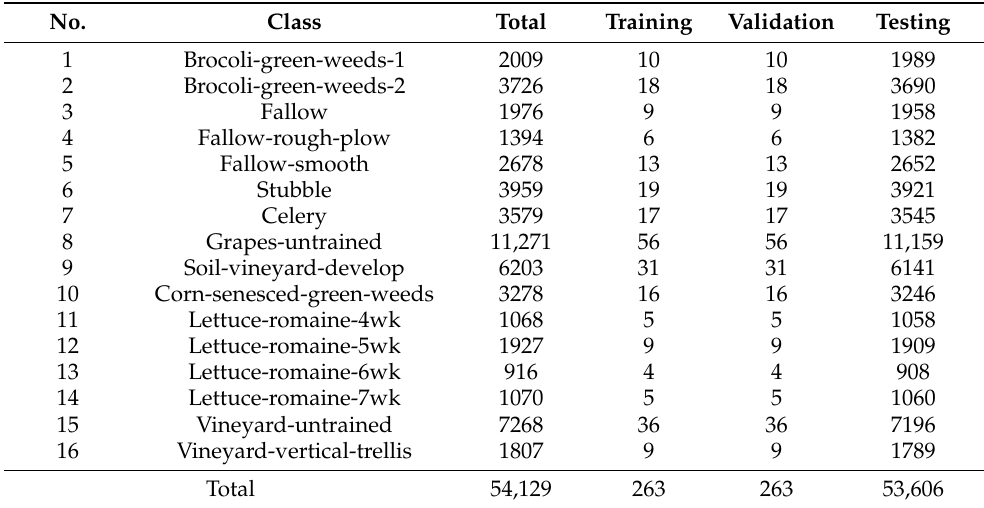
Table 2. Number of training, validation, and testing samples for the SV dataset.